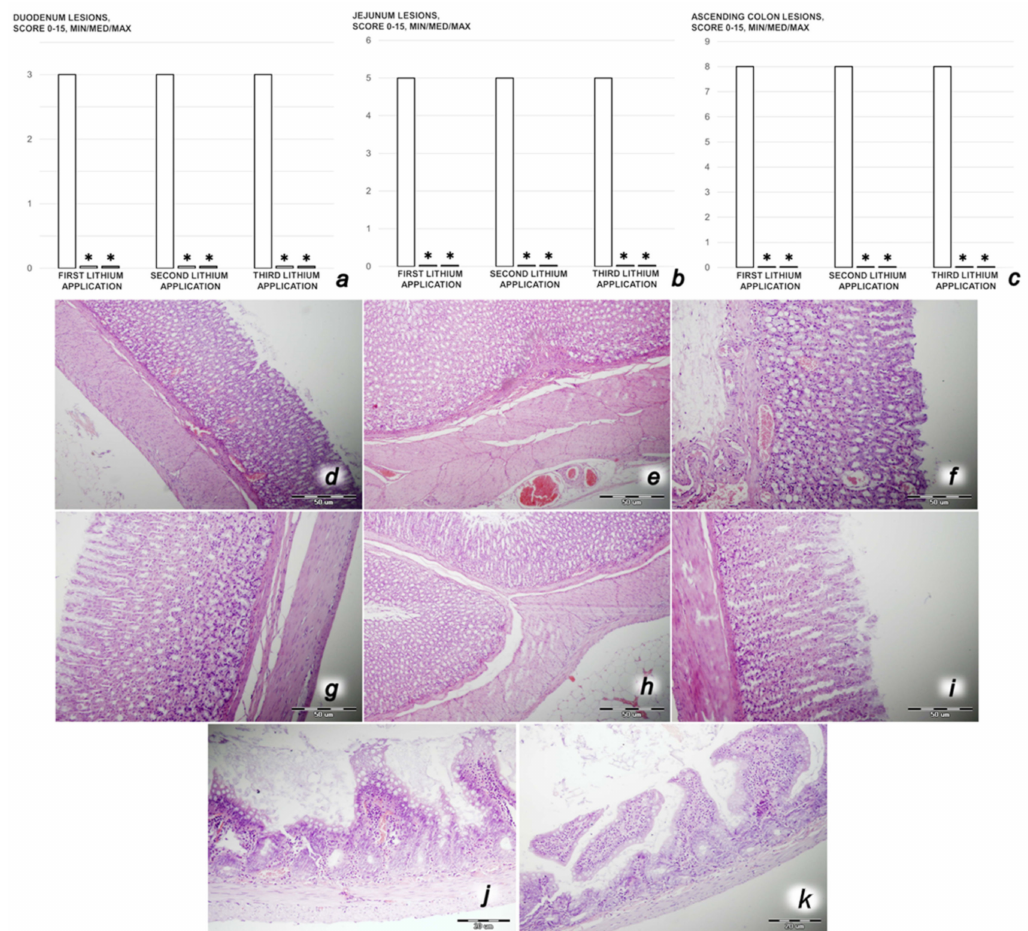
Figure 9. Gastrointestinal pathology. ( a – c ) Microscopy scoring of the lesions of the duodenum ( a ), jejunum ( b ), and ascending colon ( c ), (scored 0–15) in lithium-treated rats after the first, second, and third lithium sulphate administration (500 mg/kg/day intraperitoneally, for 3 consecutive days). BPC 157 10 µ g/kg (light gray bars), 10 ng/kg (dark gray bars); saline 5 mL/kg (white bars)) given intraperitoneally after each of the lithium administrations. Min/Med/Max, six rats/group/interval. * p < 0.05, at least, vs. control. Gastrointestinal histology. Stomach and intestine, control ( d – f , j ), BPC 157 ( g – i , k ); first lithium application ( d , g ), second lithium application ( e , h ), and third lithium application ( f , i ). A moderate to marked congestion of stomach wall was found in controls after each of the lithium administrations ( d – f ). Contrarily, lithium-treated rats that received BPC 157 regimens presented a normal gastric wall ( g – i ). An illustrative presentation of the intestinal mucosa marked congestion in the control lithium-treated rats after the third lithium administration ( j ) contrasting with the normal intestine mucosa presentation in lithium-treated rats that received BPC 157 regimens ( k ). (HE; magnification × 100, scale bar 50 µ m ( d – i ); magnification × 200, scale bar 50 µ m, scale bar 20 µ m ( j , k